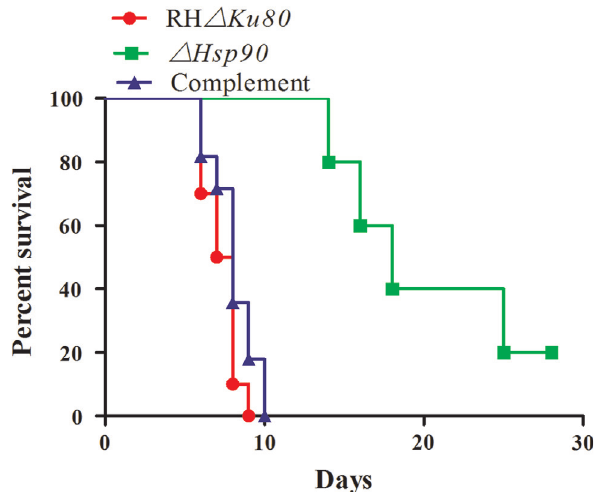
Figure 7. Virulence of Hsp90 knockouts in BALB/c mice Purified tachyzoites from different strains were intraperitoneally injected (10 3 parasites/mice) into 6–8 weeks of female BALB/c mice, 10 mice/group; the survival rate was monitored. The experiment was performed three